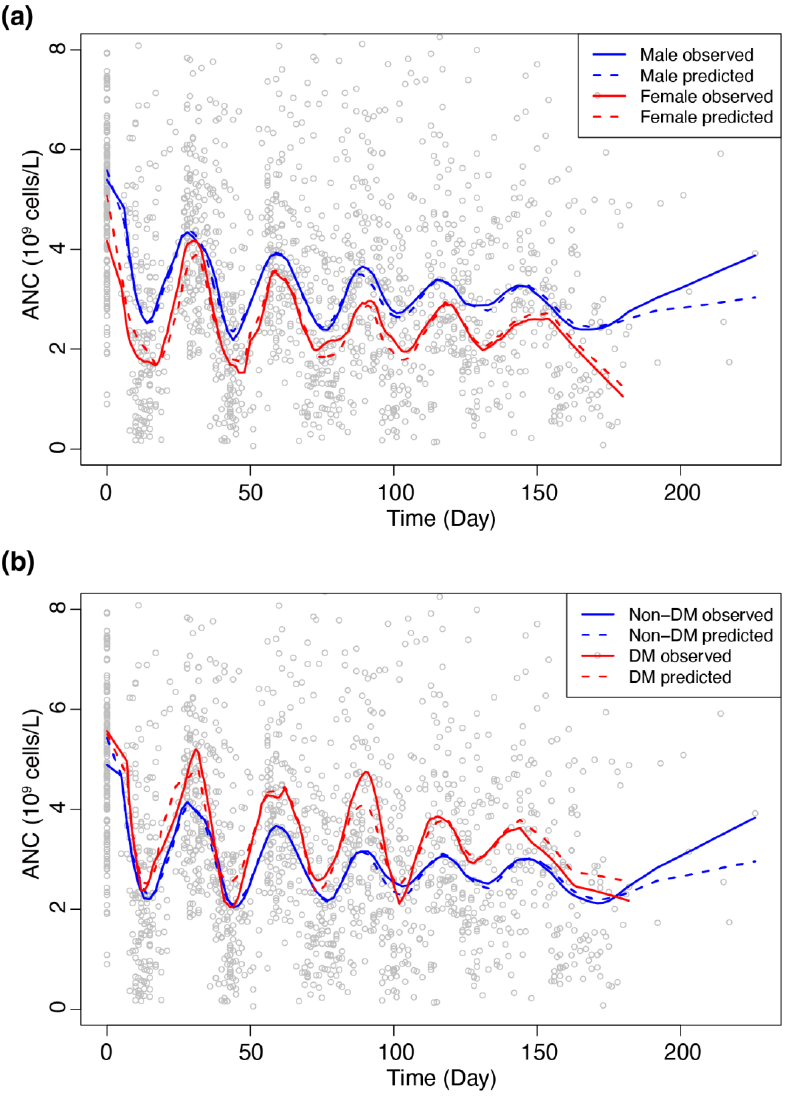
Figure 4. Averaged trajectories stratified with the selected covariates. Open circles ANC depict observations. Solid lines represent averaged observation. Dashed lines represent averaged predictions. ( a ) Blue: male, red: female. ( b ) Blue: DM, red: non-DM. Table 3. Covariate associations with DM status.